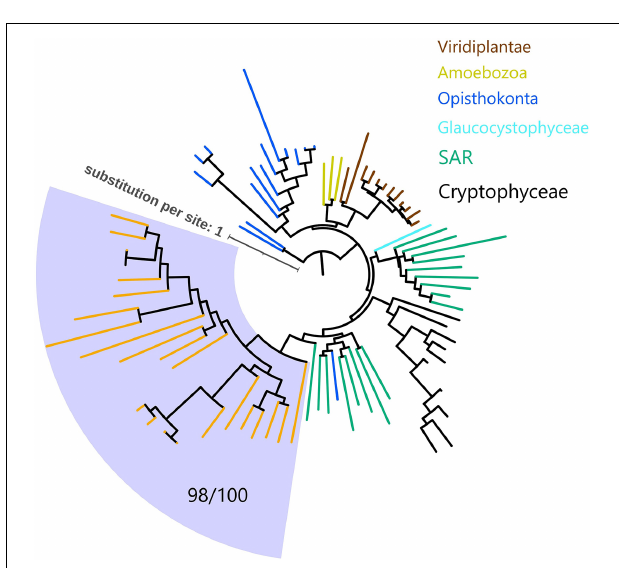
FIGURE 5 | Phylogeny of virmyosins and their close relatives in eukaryotes. The tree was built from an alignment (688 sites) of 81 myosin sequences of NCLDVs, Amoebozoa, SAR (Stramenopiles, Alveolata, and Rhizaria), Opisthokonta, Cryptophyceae, Viridiplantae, and Glaucocystophyceae. Background of the Imitervirales virmyosin clade is pale blue-colored. Branches are color-coded based on taxonomic groups (orange branches correspond to virmyosins). We consider myosin-II of Nasonia vitripennis and Neurospora crassa as outgroups to root this tree. The LG + F + R7 substitution model was selected by IQ-TREE for the best model for tree